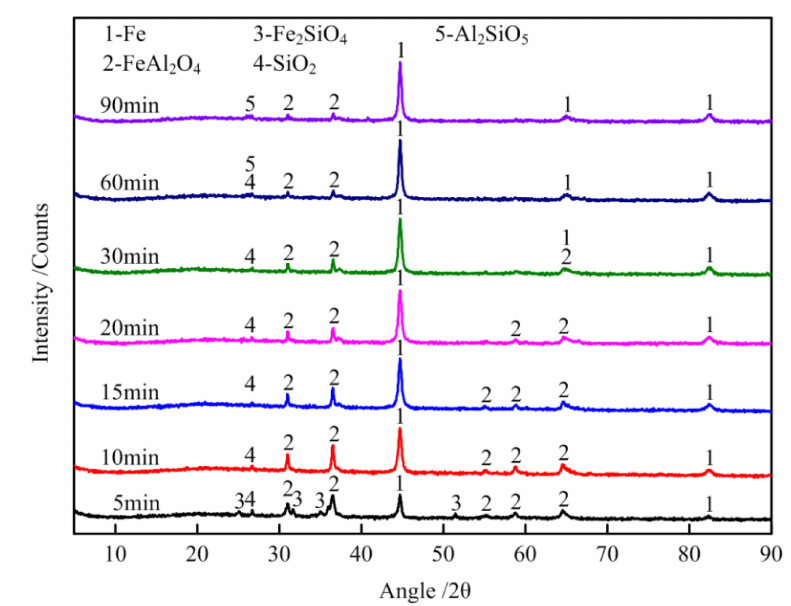
Figure 6. XRD patterns of the Fe-Al ores reduced at 1300 ◦ C under FC/O of 1.0 for different reduction roasting